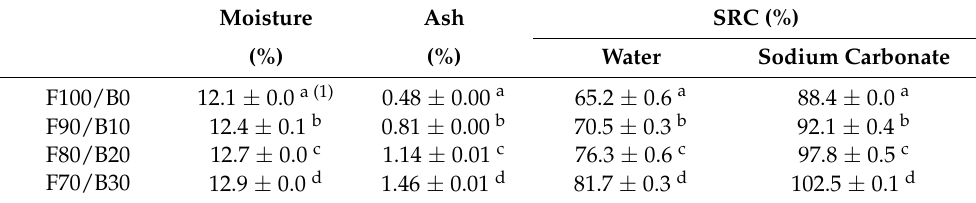
Table 2. Moisture and ash contents, and SRC values of the flour–bran blends at different ratios. Moisture Ash SRC (%) (%) (%)